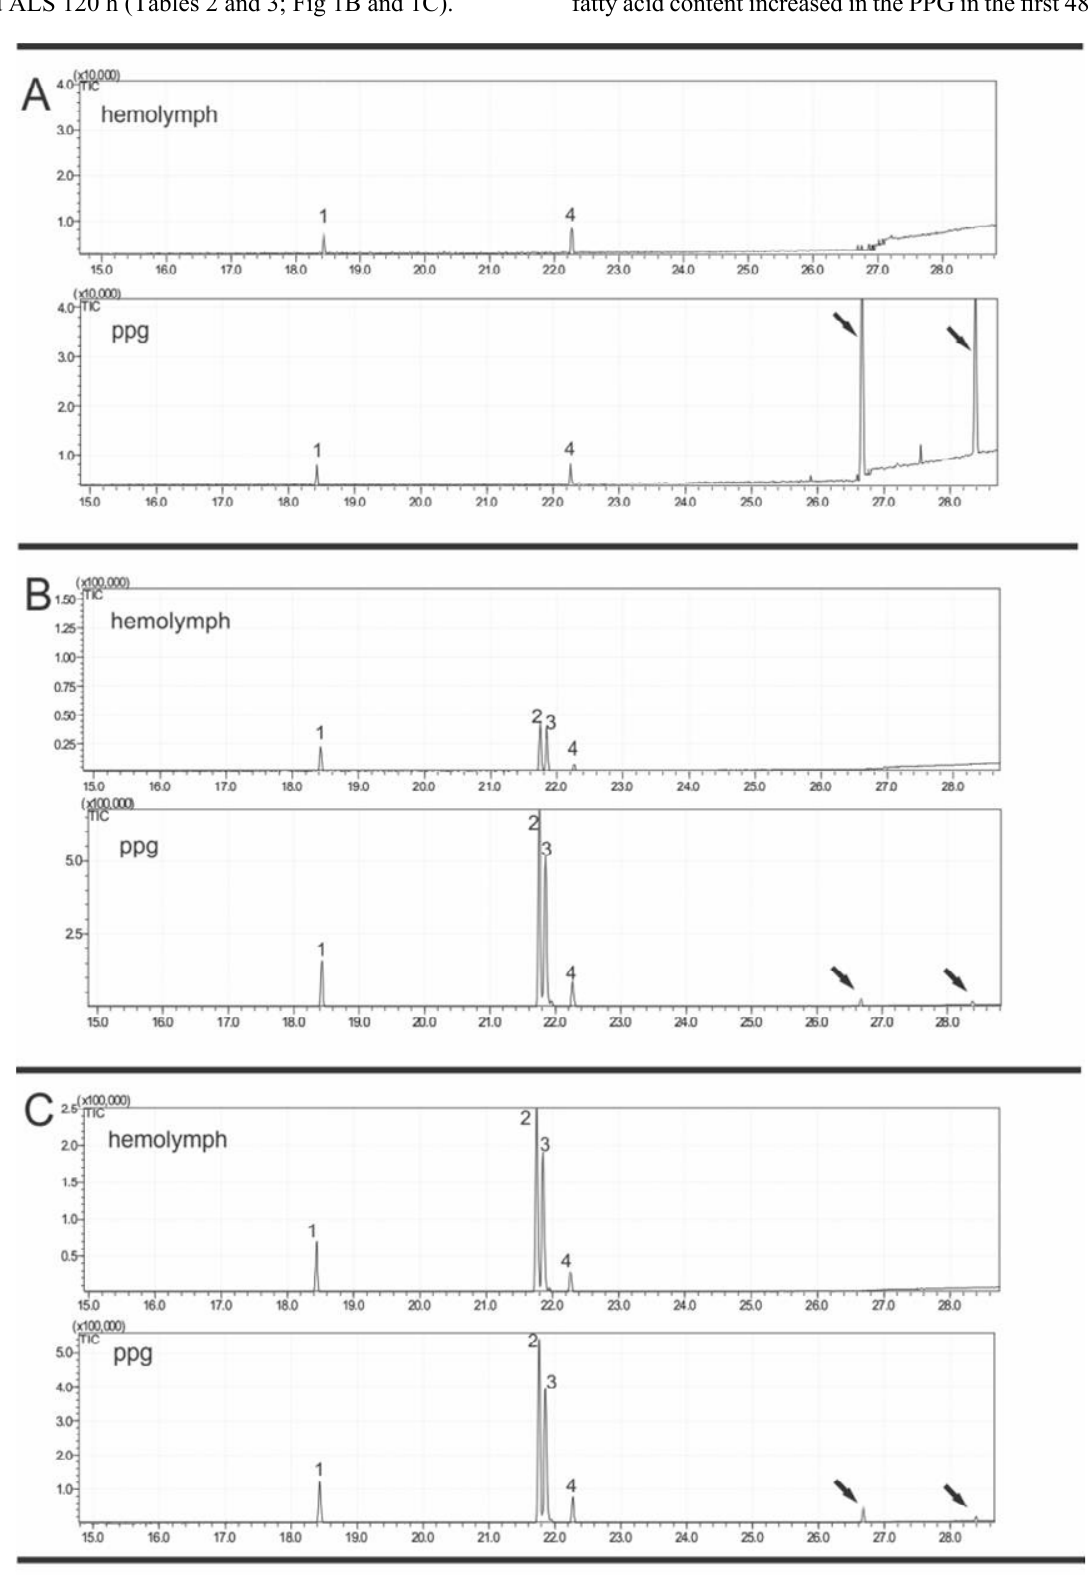
Fig 1 . Chromatographic analysis of fatty acids in the hemolymph and postpharyngeal glands (PPG) of Atta sexdens rubropilosa workers. A. Group of workers before lipid supplementation (BLS). B. Group of workers after lipid supplementation for 48 h (ALS 48 h). C. Group of workers after lipid supplementation for 120 h (ALS 120 h). 1, palmitic acid; 2, stearic acid. Arrows indicate a saturated hydrocarbon (alkane) with different retention